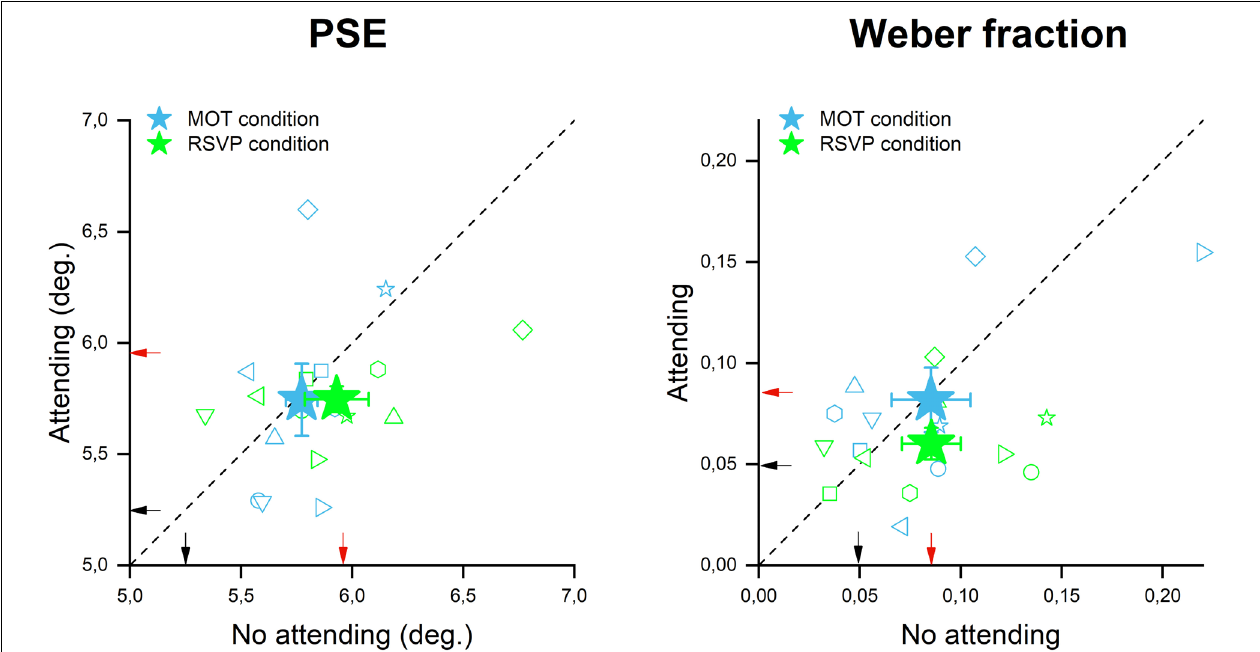
FIGURE 3 | Size adaptation effect in the presence of attentional manipulation. The scatter plot on the left represents the PSEs during the no attending (x-axis) and attending (y-axis) conditions for both attentional tasks: MOT in cyan and RSVP in green. The filled stars are the average PSE across all participants, while the small empty symbols are the performance of each participant. The scatter plot on the right represent the WFs during the no attending (x-axis) and attending (y-axis) conditions for both the attentional tasks: MOT in cyan and RSVP in green. Also in this plot, the filled stars are the average across all participants (with error bar representing ± 1 s.e.m), while the small empty symbols are the performance of each participant. The small black and red arrows indicate the PSEs and the WFs achieved in Exp 1 (in which no central stimuli were presented) for the baseline and adaptation condition